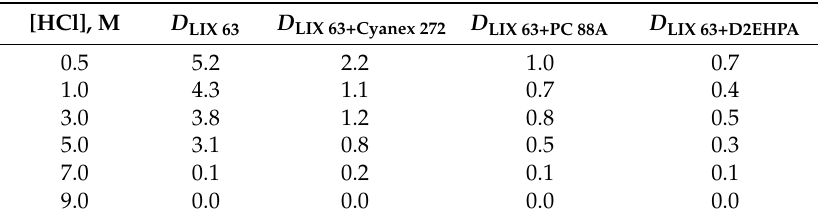
Table 6. Distribution ratio of Pd(II) with single 5,8-diethyl-7-hydroxyldodecane-6-oxime (LIX